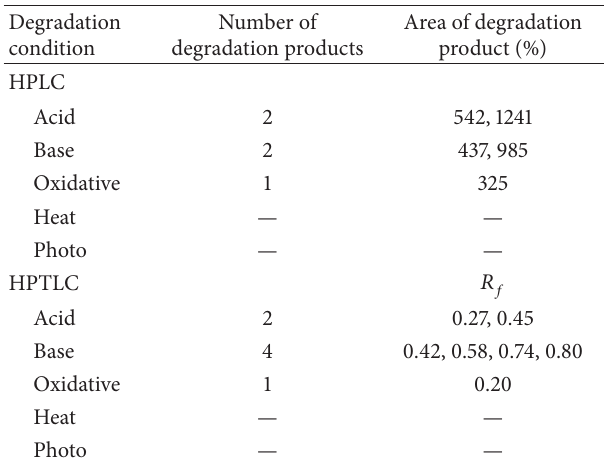
Table 5: Stability studies by HPLC and HPTLC